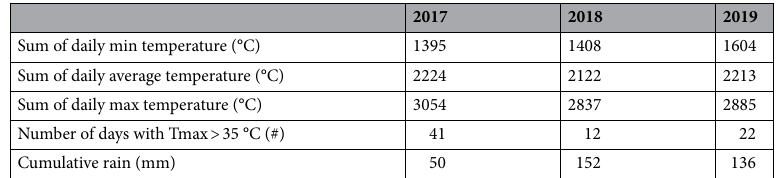
Table 2. Climatic characterization of the 2017–208–2019 seasons by calculation of the sum of daily temperature (min, average and max), number of days with Tmax > 35 °C and cumulative rain in the summer period